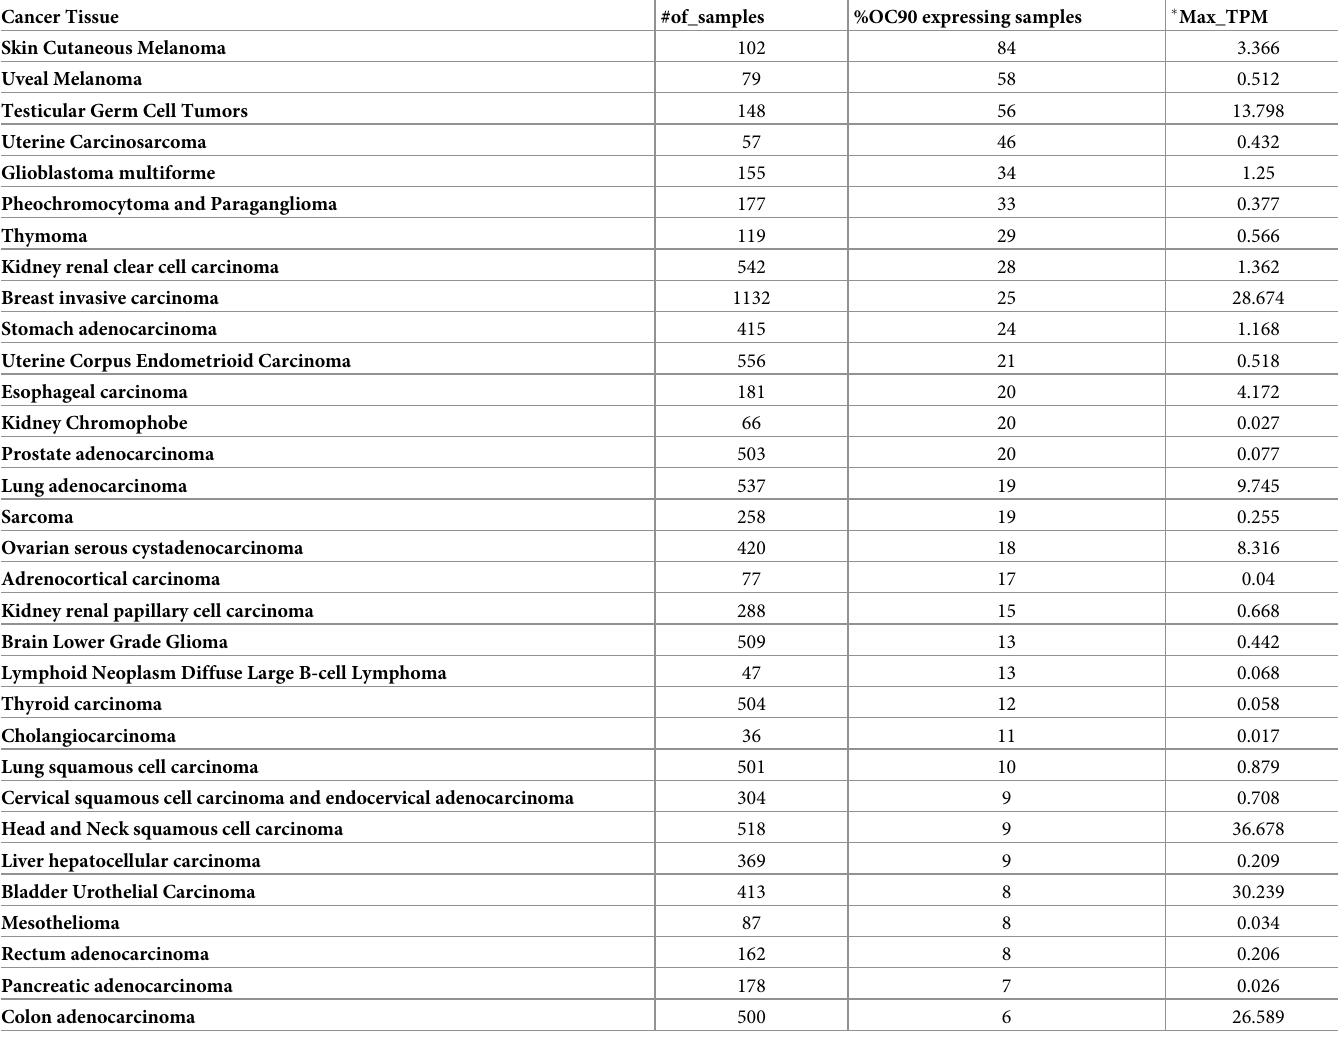
Table 1. OC90 RNAseq expression in TCGA tumor